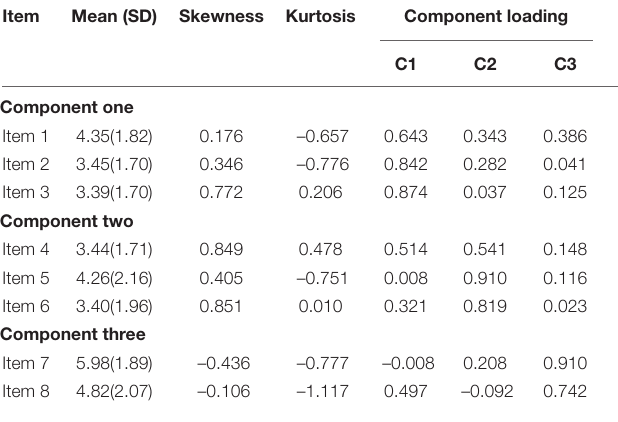
TABLE 3 | Means (SD), skewness, kurtosis, and components loadings for study one